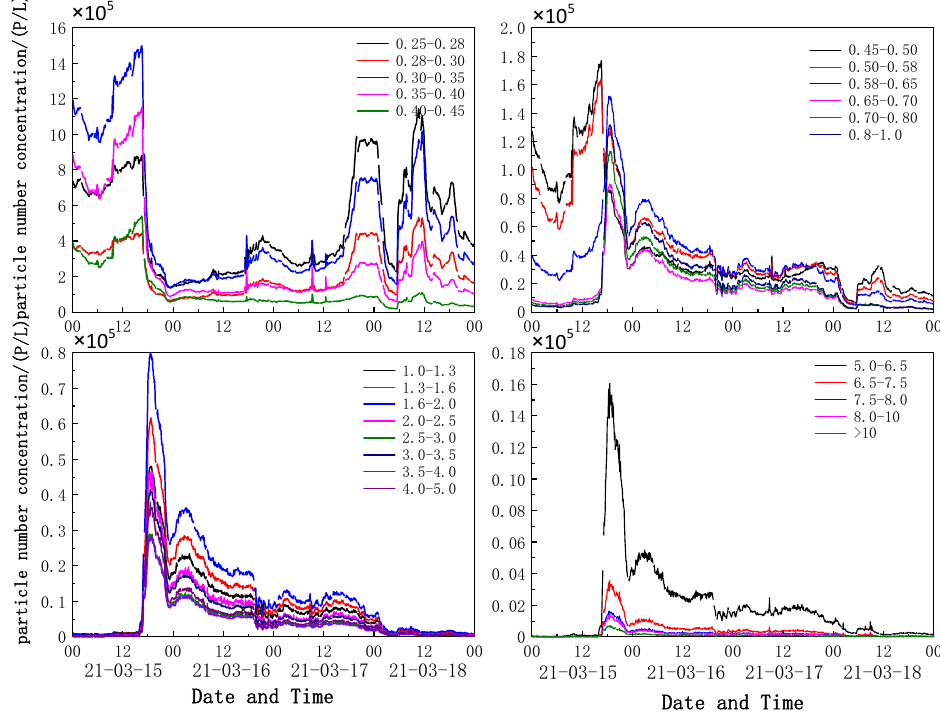
Figure 10. Number concentration of different particle size varying with time. Table 2. Number of particles in each size interval during the dust process.